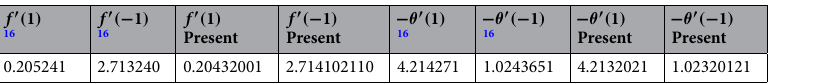
Table 6. Comparison of the present study and existing literature 16 considering common parameters φ 1 = φ 2 = M = Q = 0, Re = 1, Pr =